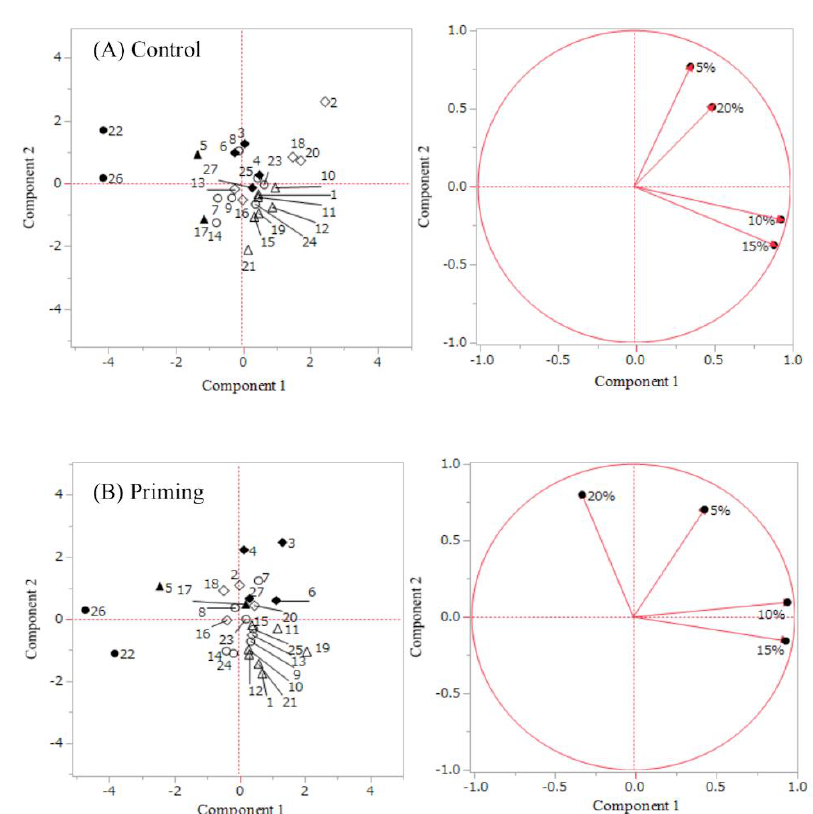
Figure 3. Results of principle component analysis of 27 genotypes based on mean emergence time (MET). ( A ) and ( B ) shows result of control and priming, respectively. Component 1 and 2 of ( A ) accounted for 51.5 and 25.9, respectively. Component 1 and 2 of ( B ) accounted for 52.2 and 29.2, respectively. MET was modified to negative values and analyzed. Each number shows one genotype (genotype numbers are illustrated in Table 1). Black circles, black rhombuses, white circles, white rhombus, black triangles and white triangles indicate genotype group1, 2, 3, 4, 5 and 6, respectively. Genotype groups are determined by cluster analysis (illustrated in Figure